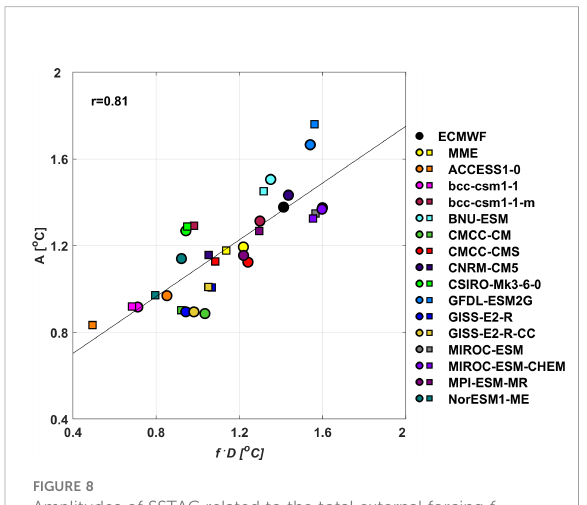
FIGURE 8 Amplitudes of SSTAC related to the total external forcing f , which includes the annual and semi-annual components, multiplied by the dynamical response factor D, based on ECMWF reanalysis dataset (black circle), MME and each of 15 models in the historical period (colored circles) and RCP4.5 scenario (colored squares).